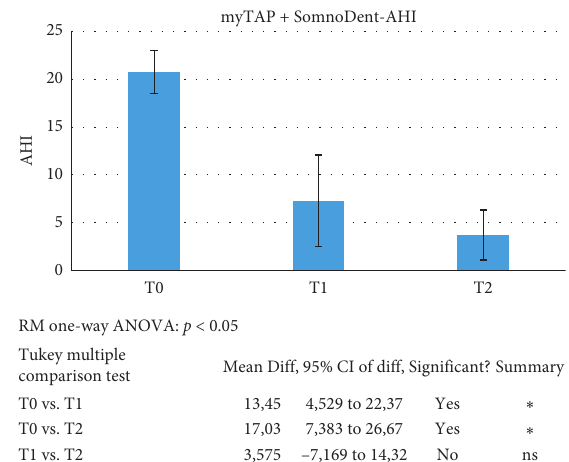
Figure 9: ANOVA and post hoc Tukey test were applied to evaluate the efficacy of the proposed therapeutic pathway: the trial (T1) followed by definitive device (T2). Significance for all statistical tests was set at p < 0 . 05 (C1).